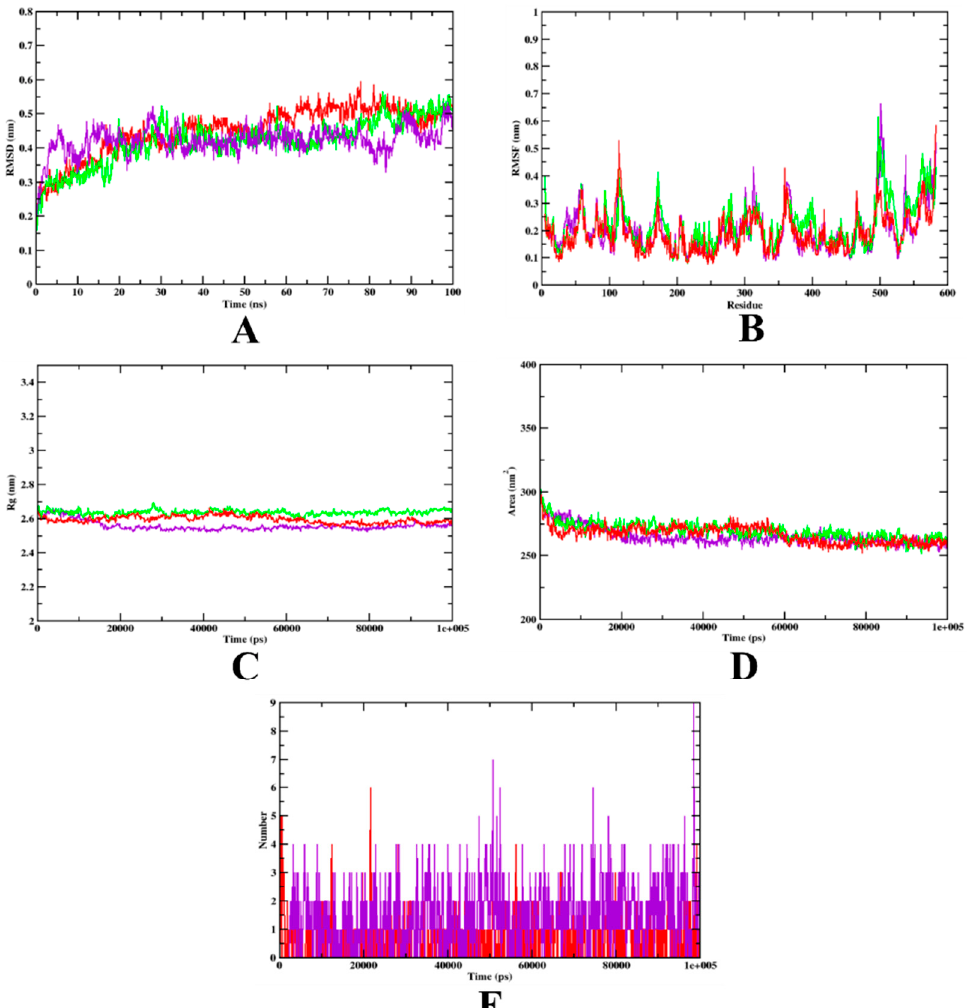
Figure 8. Analysis of RMSD, RMSF, Rg, SASA, and the number of hydrogen bonds of isoeugenol- (purple) and aminoguanidine-bound (red) HSA complex, as well as apo-protein HSA (green), at 100 ns. ( A ) Time evolution of RMSD values of both the complexes, along with the protein. ( B ) RMSF. ( C ) Radius of gyration (Rg). ( D ) SASA. ( E ) Hydrogen bonds. Table 7. MD trajectory values of isoeugenol and aminoguanidine complexed with HSA.